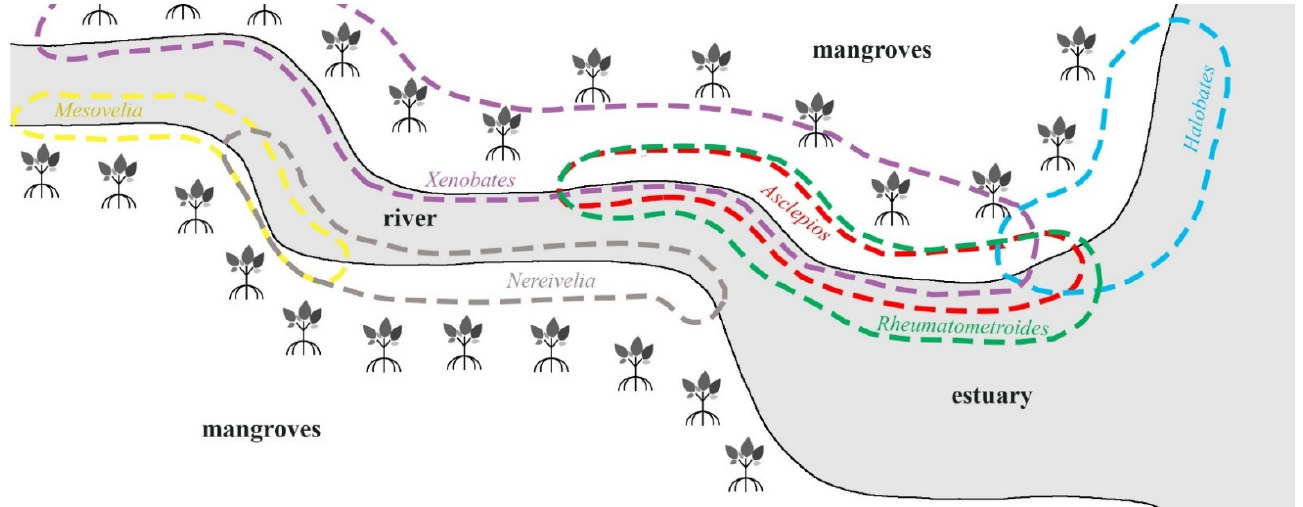
Figure 3. Preferred mesohabitats of marine Gerromorpha in mangroves of central and eastern re- gions.